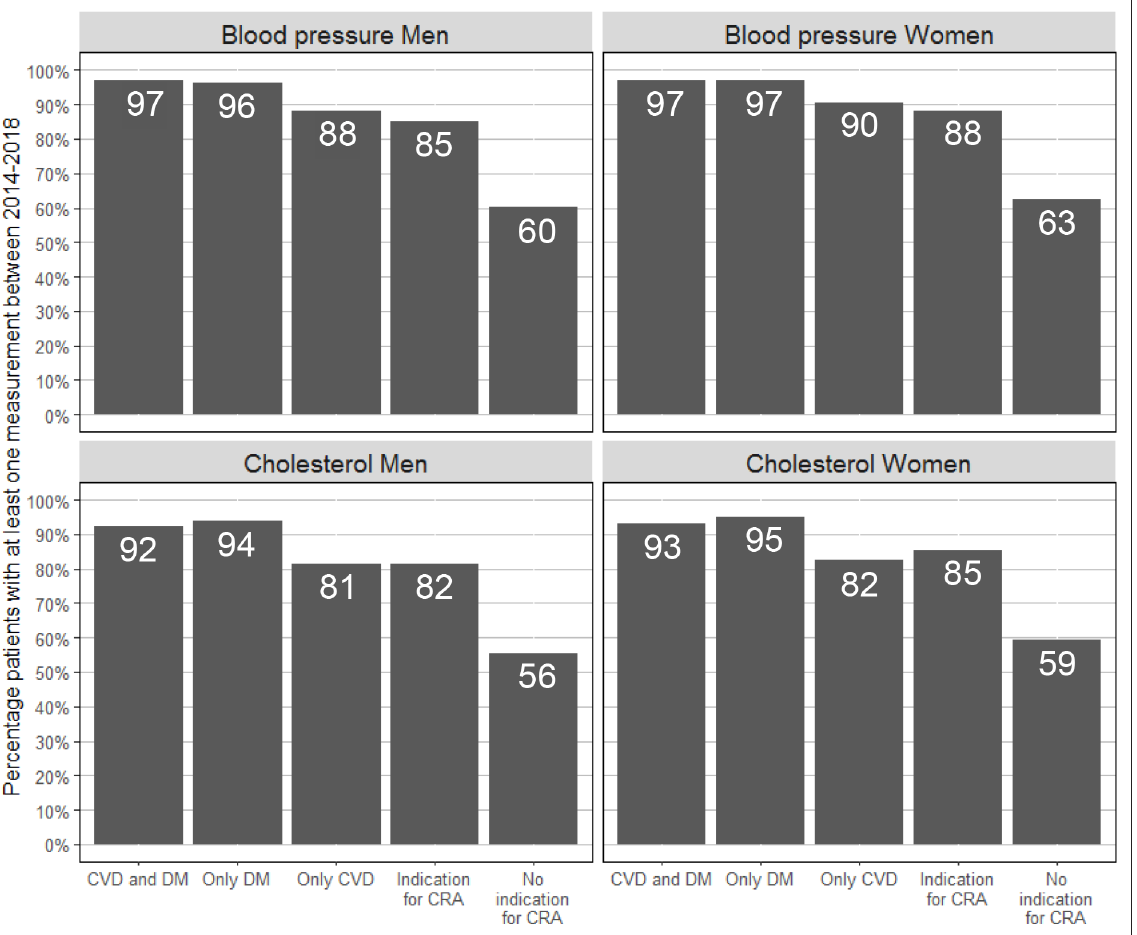
Figure 4 Men aged ≥40 years and women aged ≥50 years with at least one measurement between 2014 and 2018. CRA = cardiovascular risk assessment. Patients were classified as ‘Indication for CRA’ if they did not have a history of CVD or DM, but did have a history of one of the following: rheumatoid arthritis, pre- eclampsia, pregnancy- induced DM, family history of CVD, obesity, smoking, hypertension, dyslipidaemia, chronic kidney disease, use of antihypertensive or lipid- lowering medication. CVD = cardiovascular disease. DM = diabetes